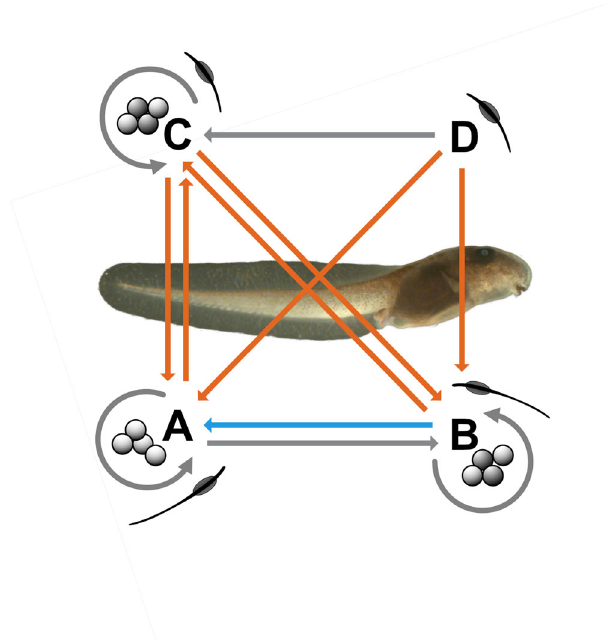
Fig. 4 Summary of the effects of male (population) origin on fi tness- related traits in P. guentheri hatchlings, where orange arrows denote negative effects, blue arrows positive effects and grey arrows neutral effects. Arrow directions indicate the mixing of sperm with eggs in populations A, B and C. As we did not obtain gravid females from population D, only crosses between populations A, B and C were reciprocal. The background image shows an example of a BB hatchling, and sperm images indicate different sperm morphology between A/B and C/D